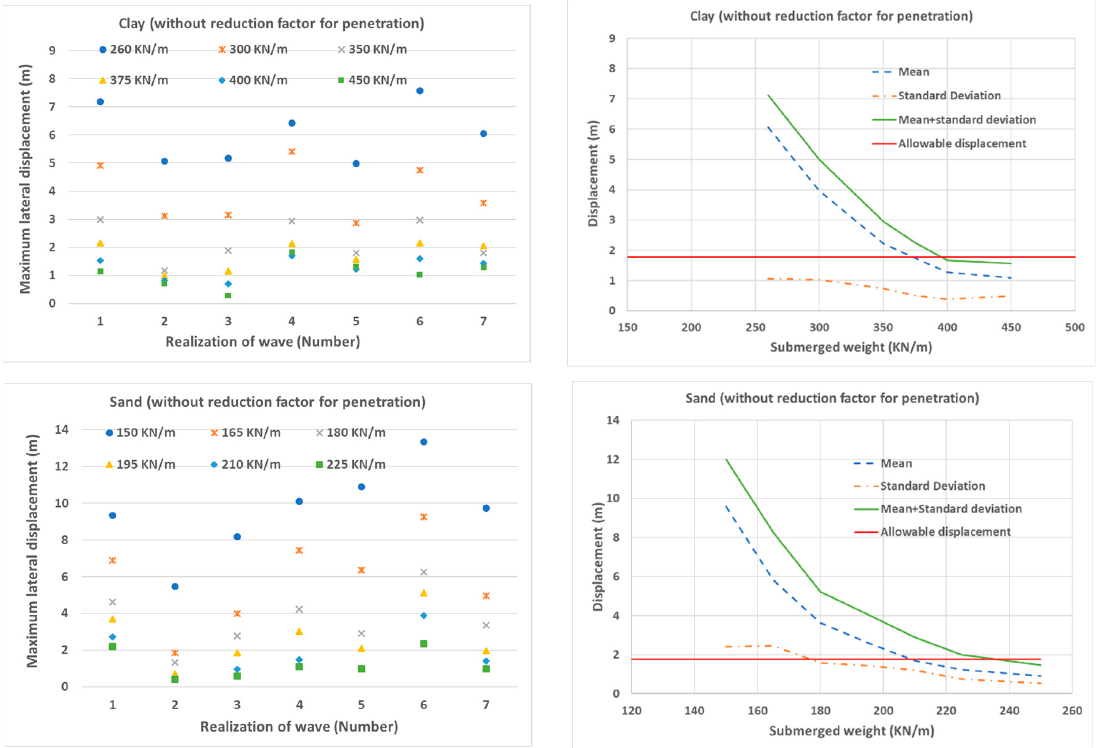
Figure 5. The lateral displacement of the umbilical for seven wave realizations and the mean and standard deviation of lateral displacement (cases without reduction factor).